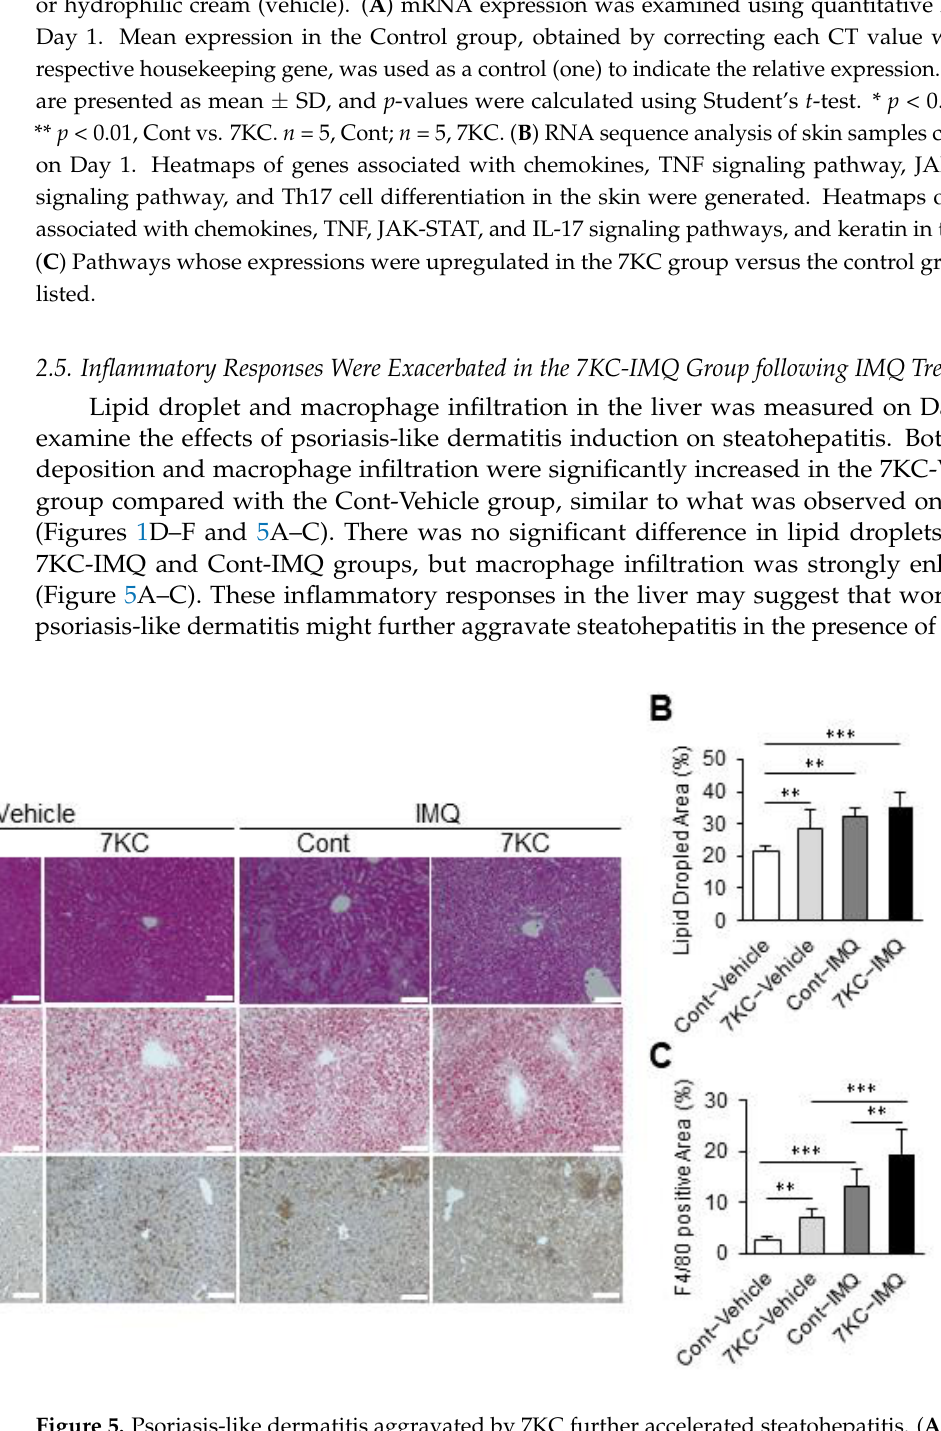
Figure 5. Psoriasis-like dermatitis aggravated by 7KC further accelerated steatohepatitis. ( A ) Hema- toxylin and eosin (H.E.) staining, oil red O (O.R.O) staining, and F4/80 staining of liver on Day 4. ( B )